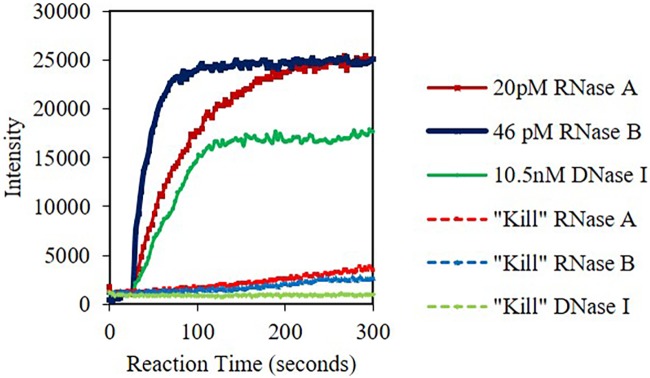
Fluorescent intensity at 520 nm (RNase A/B) and 556 nm (DNase I) versus time for nucleases post Lyse-It.RNase A and B 98% inactivation was achieved through 3 irradiations with Lyse-It of 70% power, 105 seconds. DNase I was 99% inactivated at 50% power for 60 seconds with Lyse-It.